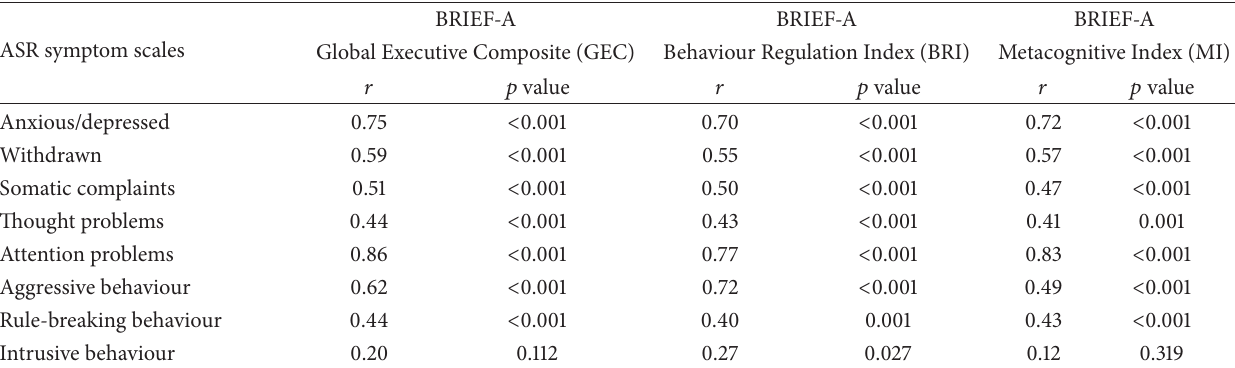
Table 9: Associations between main indexes on BRIEF-A and symptom scales on ASR at 2–5 years after moderate and severe